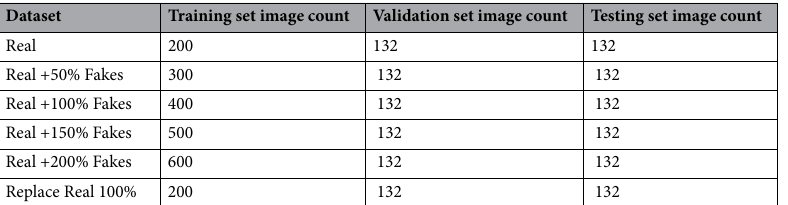
Table 5. Augmentation and anonymity data sets.